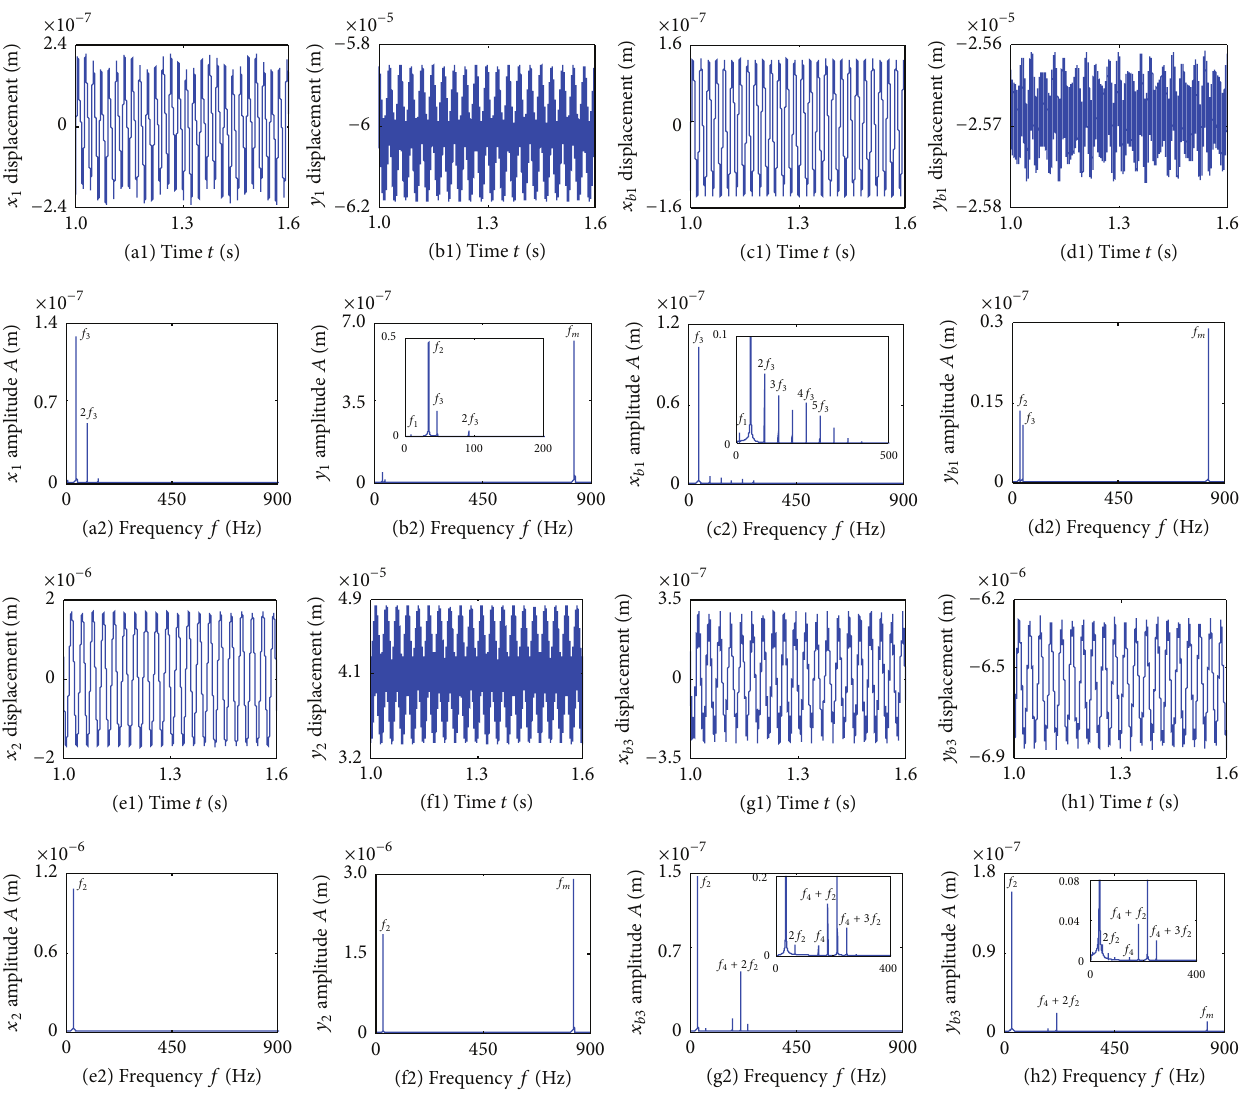
Figure 4: Lateral waveform and frequency spectrum at 𝑛 1 = 500 r/min, 𝜌 1 = 2.0 × 1 0 −6 m, and 𝜌 2 = 2.0 × 1 0 −5